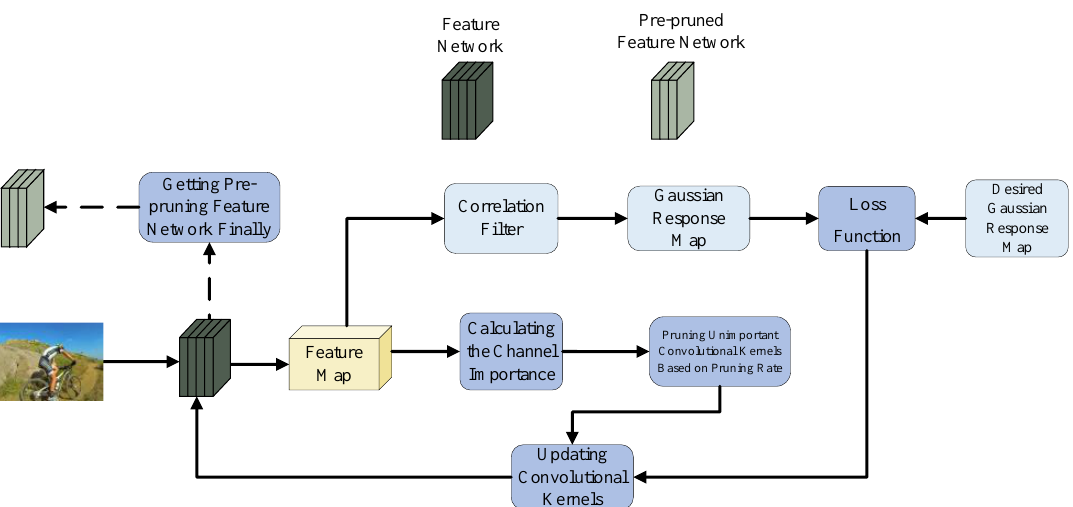
Figure 2. PCIP-based pre-pruning of the deep convolutional feature network. Using F i , j to denote the feature map corresponding to the jth convolutional kernel in the ith convolutional layer, of which the size is R i , j × C i , j , then the importance score Score i , j of the jth convolutional kernel in the ith convolutional layer can be derived from Equation (1)